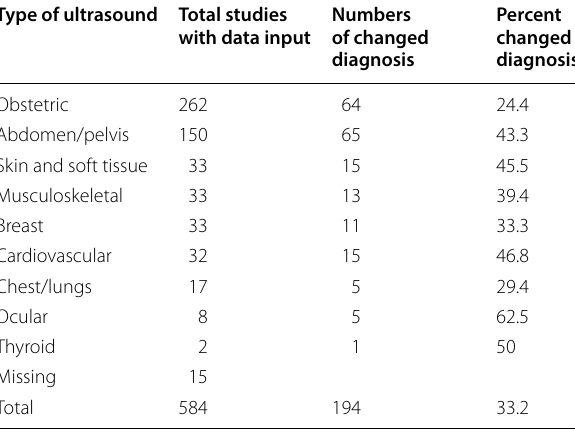
Table 3 The frequency for which POCUS changed patient diagnosis in each of the different types of ultrasound examinations